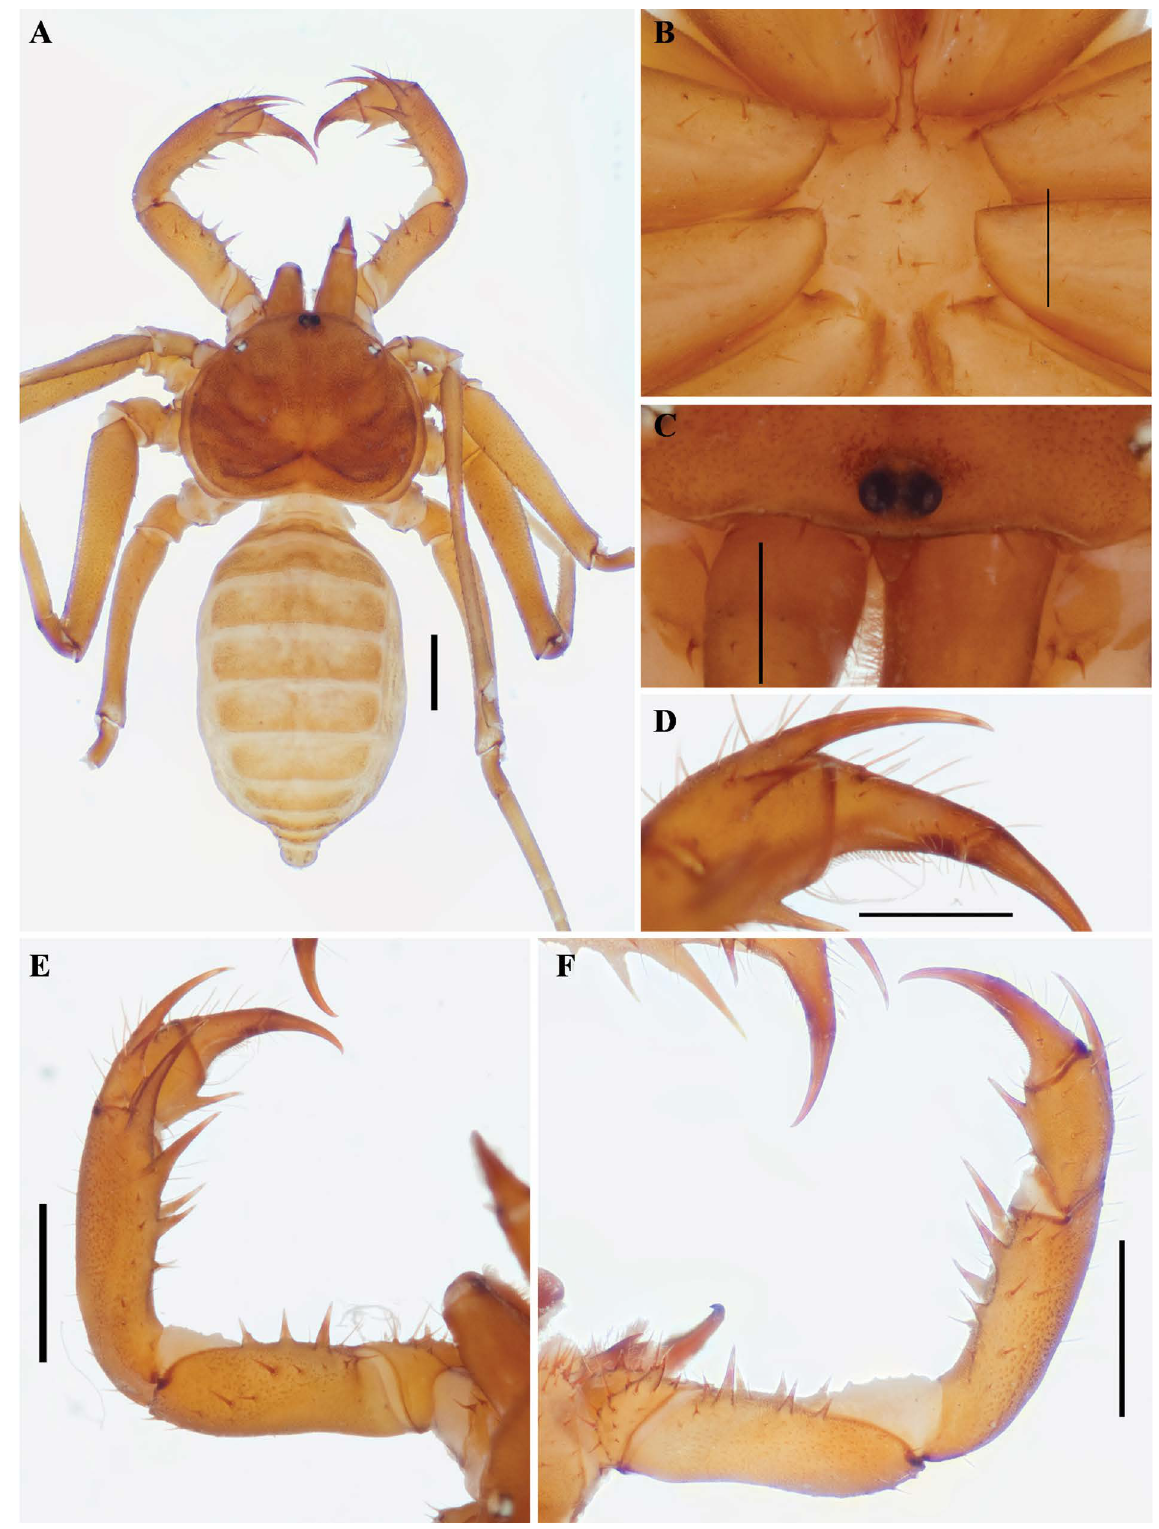
Fig. 118. Sarax palau sp. nov. (FMNH 3489487), general morphology, ♀. A . Habitus, dorsal view. B . Sternum, ventral view. C . Frontal process. D . Pedipalp tarsus, frontal view. E . Pedipalp, dorsal view. F . Pedipalp, ventral view. Scale bars: A, E–F = 1 mm; B–D = 0.5